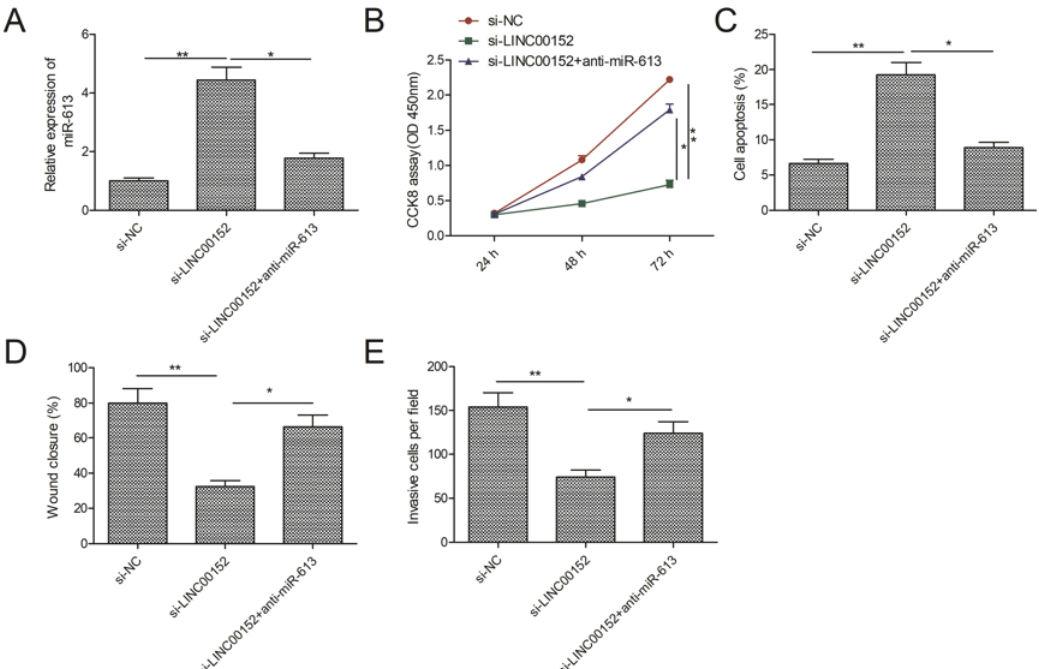
Figure 5: The miR-613 inhibition abrogated the effects of LINC00152 depletion on cell proliferation, migration and invasion in LSCC. (A) The expression of miR-613 was determined in TU212 cells transfected with si-NC, si-LINC00152, si-LINC00152+ miR-613 inhibitor (anti-miR-613) by qRT-PCR. (B-E) Cell proliferation, apoptosis, migration and invasion were determined in TU212 cells transfected with si-NC, si-LINC00152, si-LINC00152+ anti-miR-613. * P< 0.05; **P <